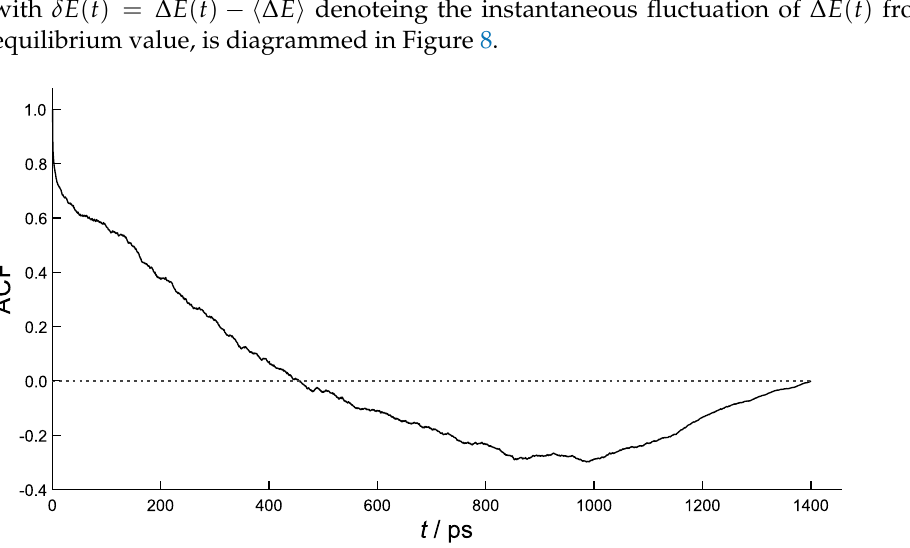
Figure 8. Autocorrelation function ACF = (cid:104) δ E ( 0 ) δ E ( t ) (cid:105) / (cid:104) ( δ E ) 2 (cid:105) averaged over 3 simulations.